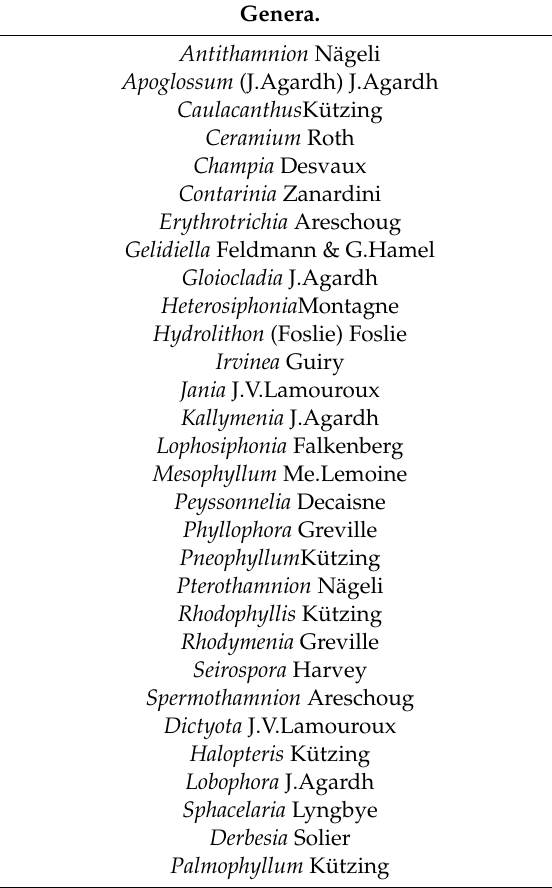
Table 3. Macrophytobenthic component present on the collected drift